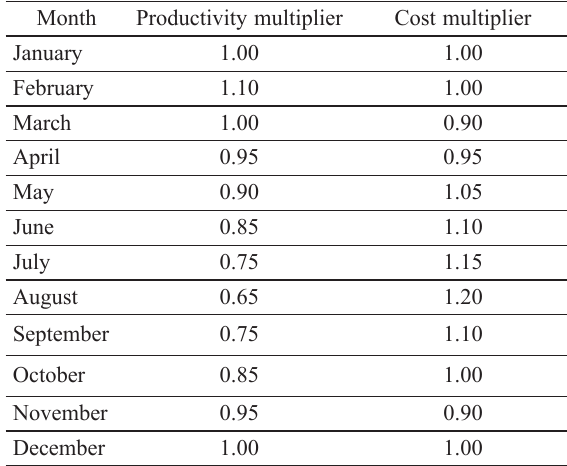
Table 3. Productivity and cost multipliers